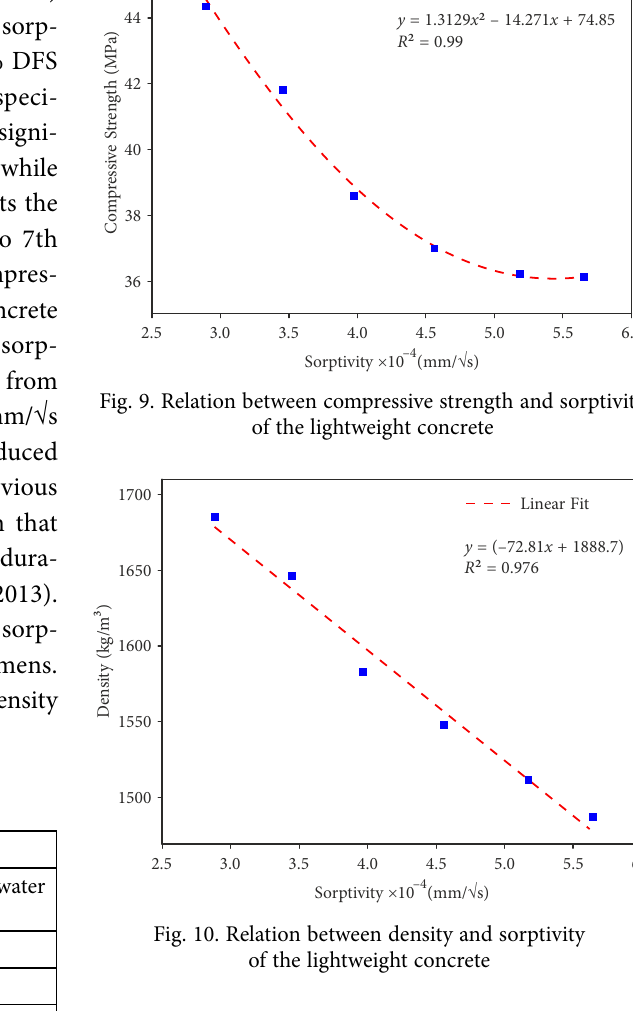
Table 6. Saturated water absorption of lightweight